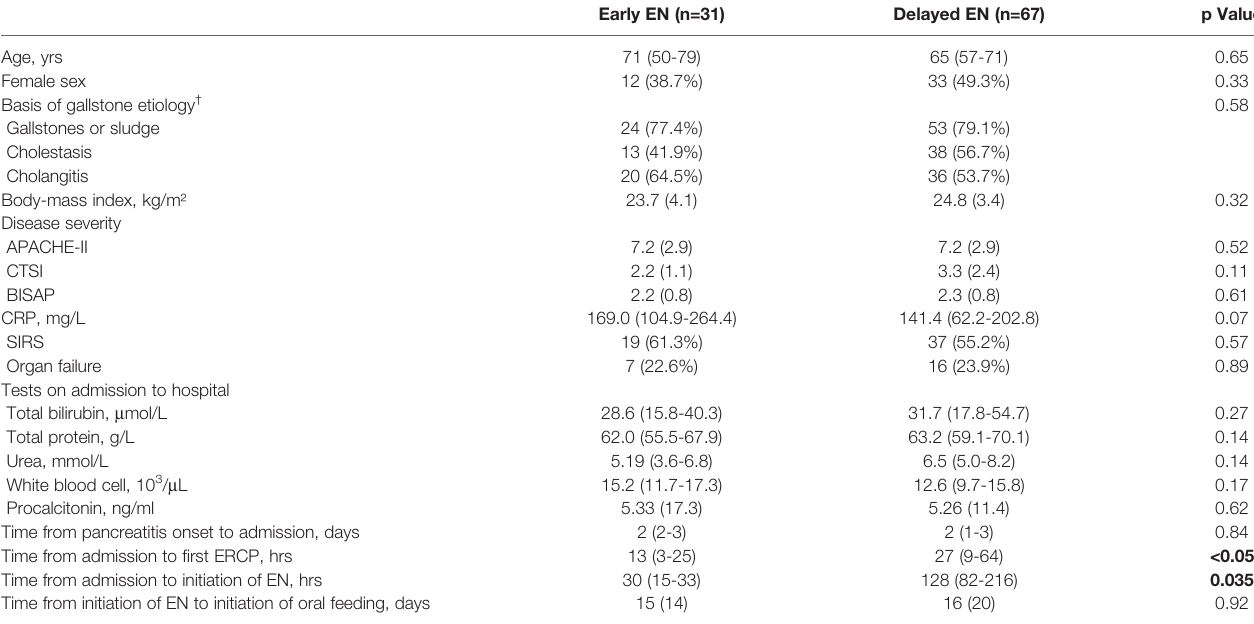
TABLE 1 | Baseline demographic and clinical characteristics of